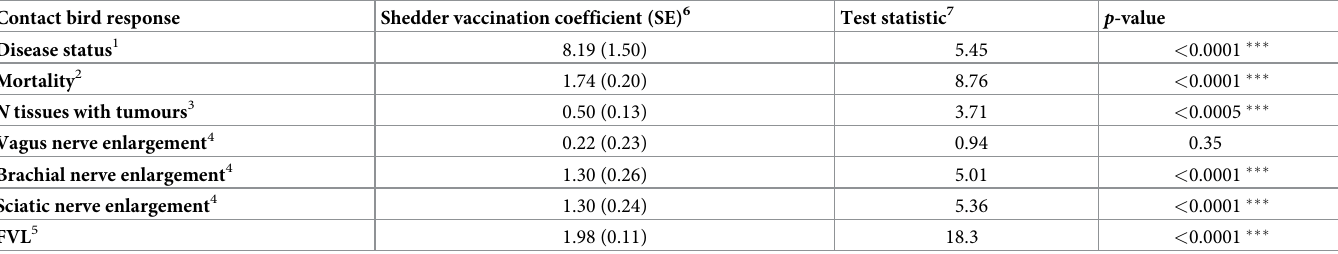
Table 1. Effects of shedder vaccination status on contact bird disease symptoms, mortality and FVL for a model also including contact bird sex and shedder DPI, but excluding DPI by vaccination status interaction. Full results, including models with the interaction, are in S1 Table. Contact bird